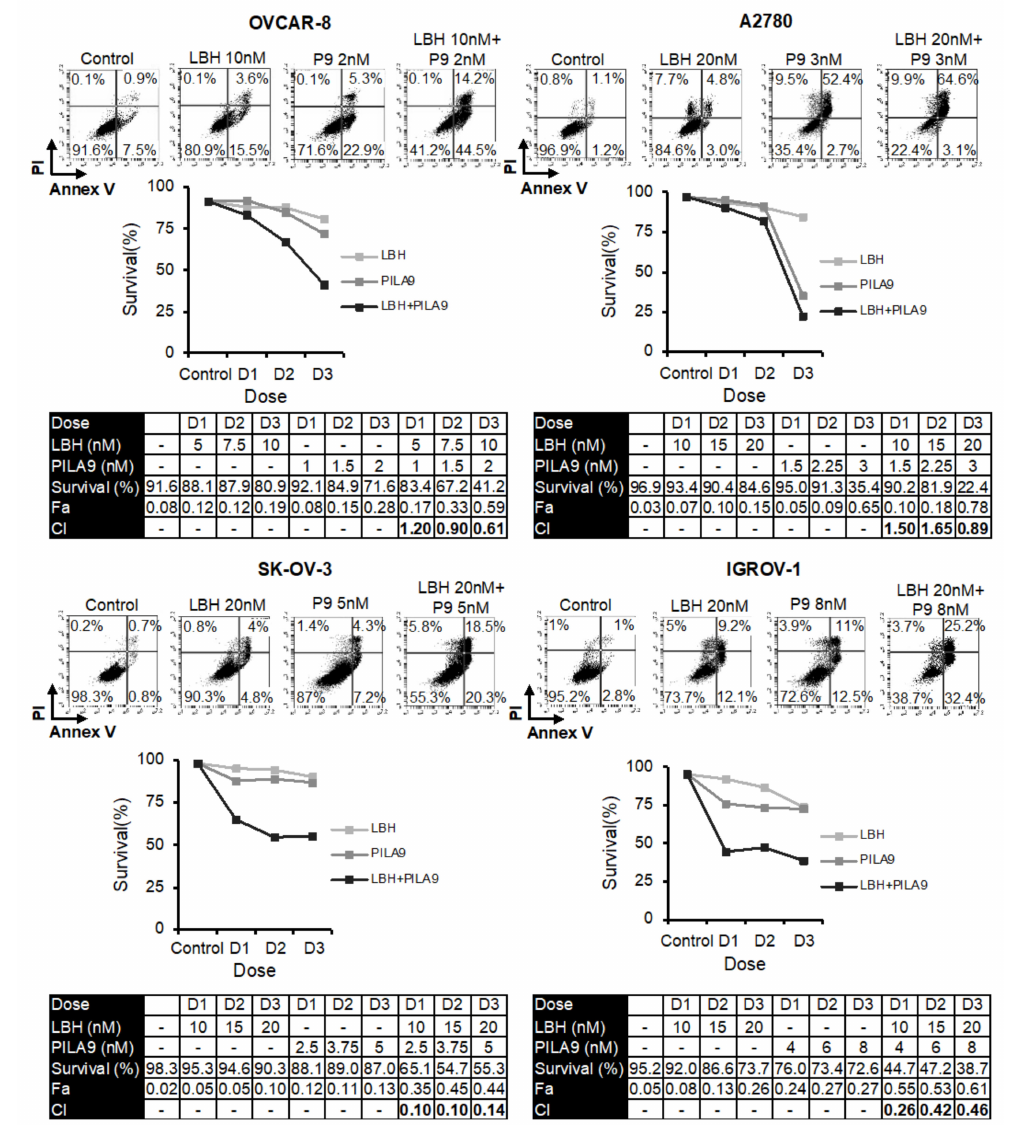
Figure 5. Synergistic effect of LBH and PILA9 in OCCLs. Cells were exposed for 72 h to the indicated concentrations of LBH and PILA9 at a constant ratio, and the percentage of apoptotic cells was assessed by flow cytometry (after cell staining with annexin V and propidium iodide). CI values, calculated using Compusyn Software, are